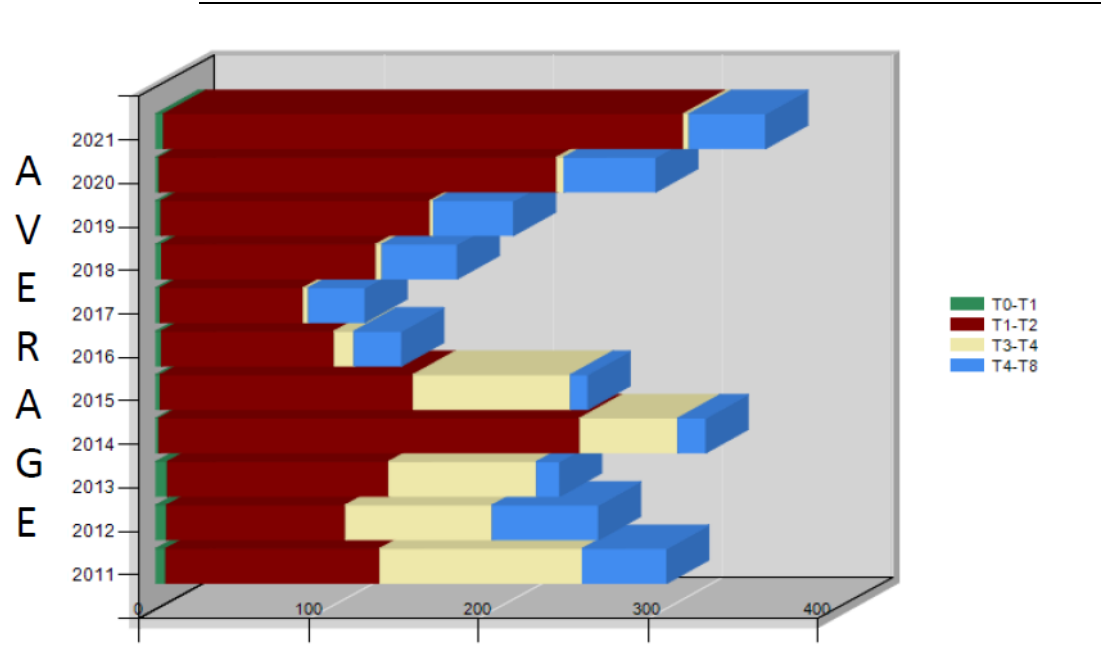
Figure 2. Iglesias: annual averages of the time intervals of the process (days) for 2011–2021. Table 2 – Iglesias summary data: applications, ASL and INPS reports, average times of procedure ASL-INPS